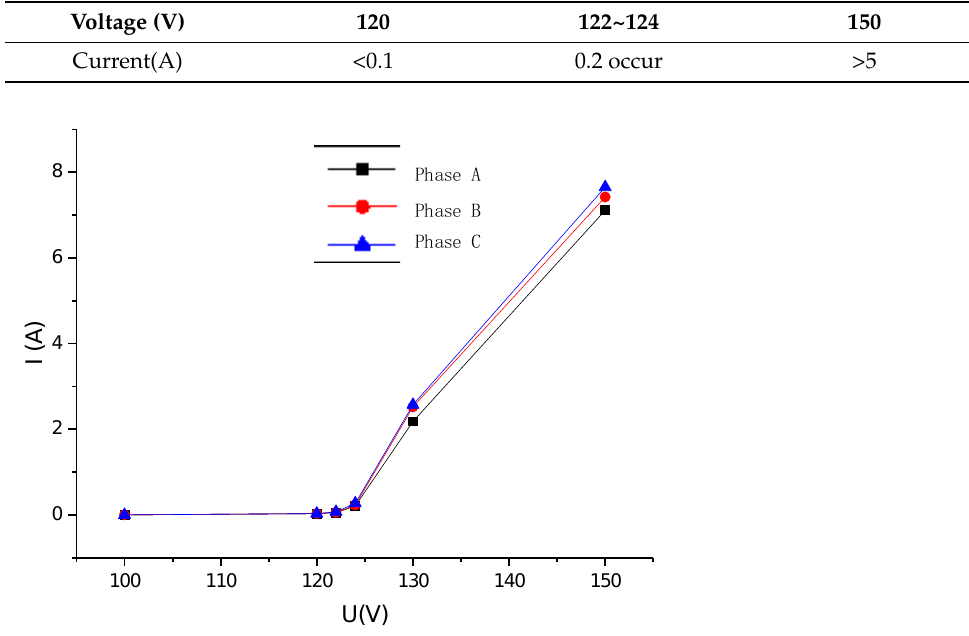
Table 5. The qualified standard for voltage–current characteristics of dampers.